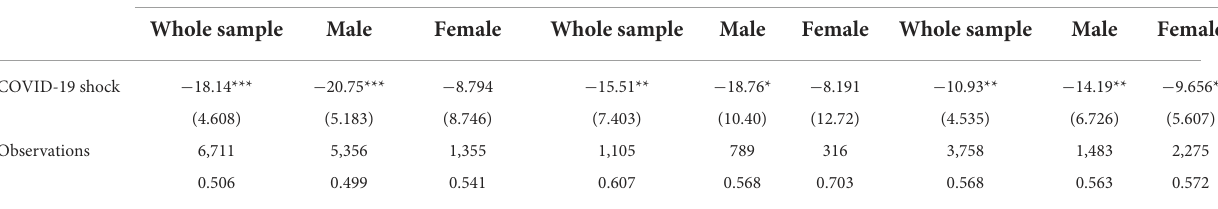
TABLE 9 Heterogeneous analysis of